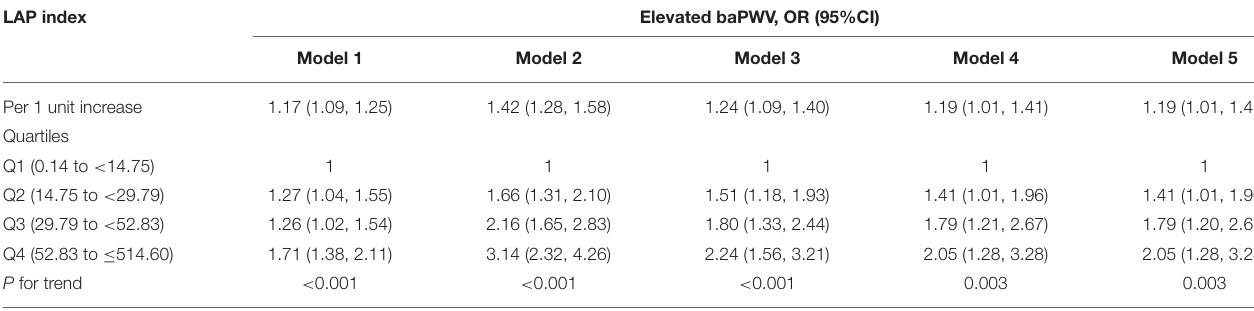
TABLE 4 | The association between LAP and elevated baPWV in different models.